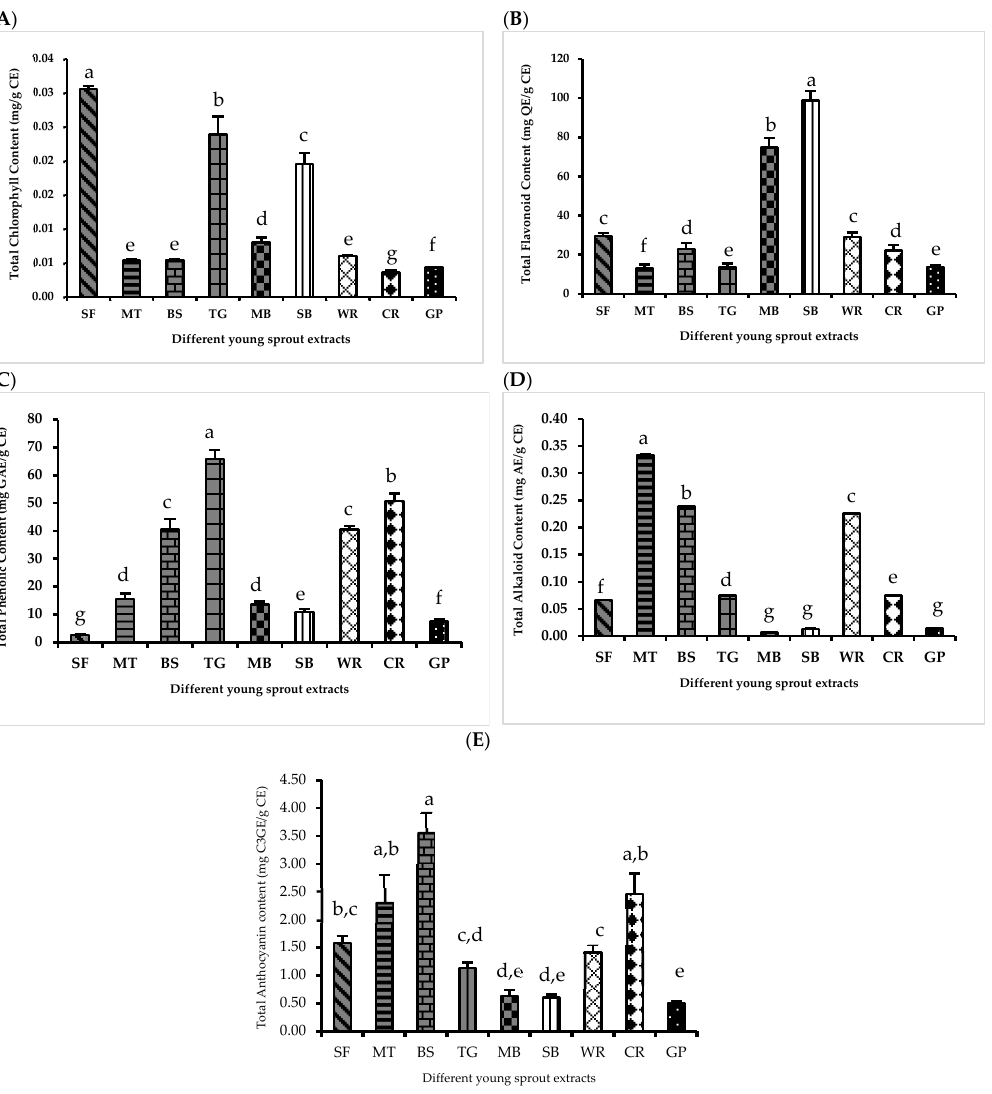
Figure 3. ( A ) TCC, ( B ) TFC, ( C ) TPC, ( D ) TALC, and ( E ) TAC. Data are expressed as mean ± SD from fi ve replicates. Di ff erent le tt ers (a–g) indicates a signi fi cant di ff erence between samples ( p < 0.05).